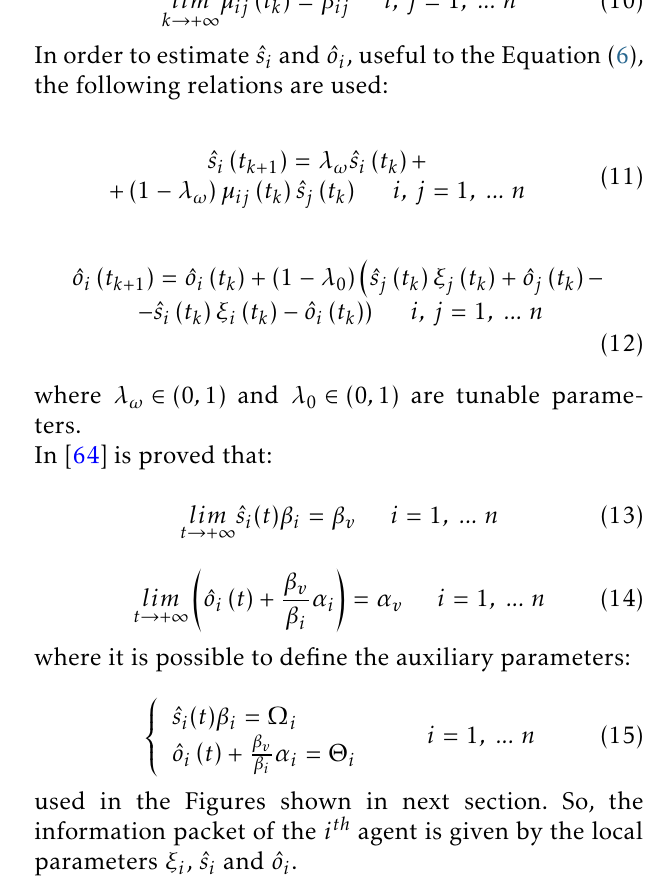
Figure 5. The generic node N source, the power converter and the